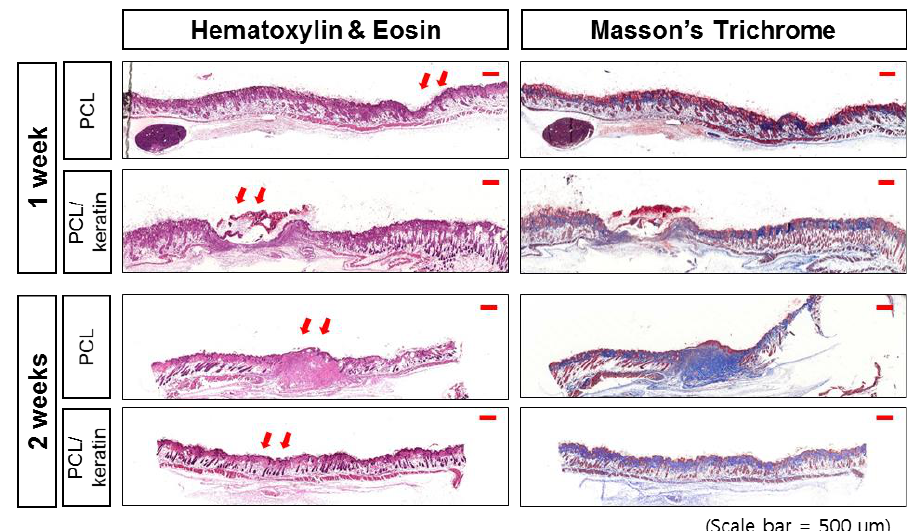
Figure 8. Staining results of the implanted PCL and PCL/keratin scaffolds. The production of collagen in the dermal layer is important for skin